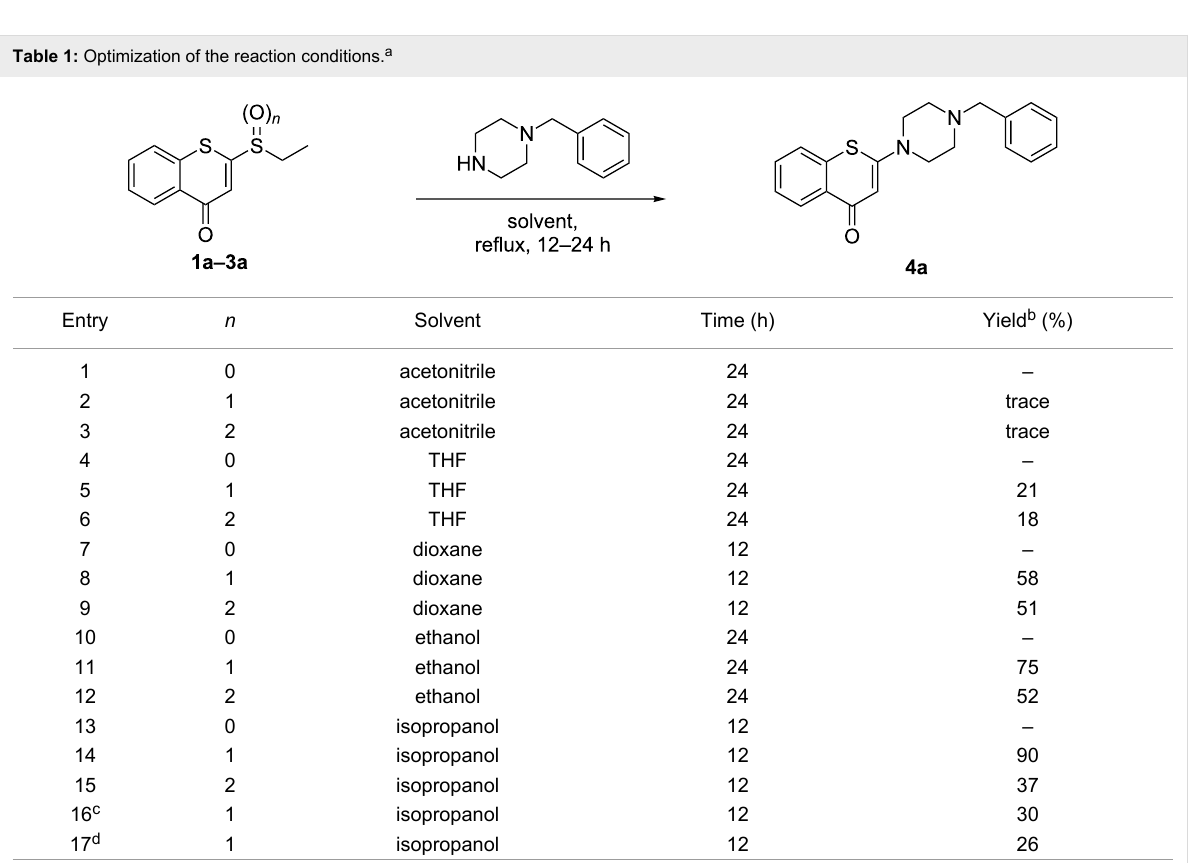
Table 1: Optimization of the reaction conditions.